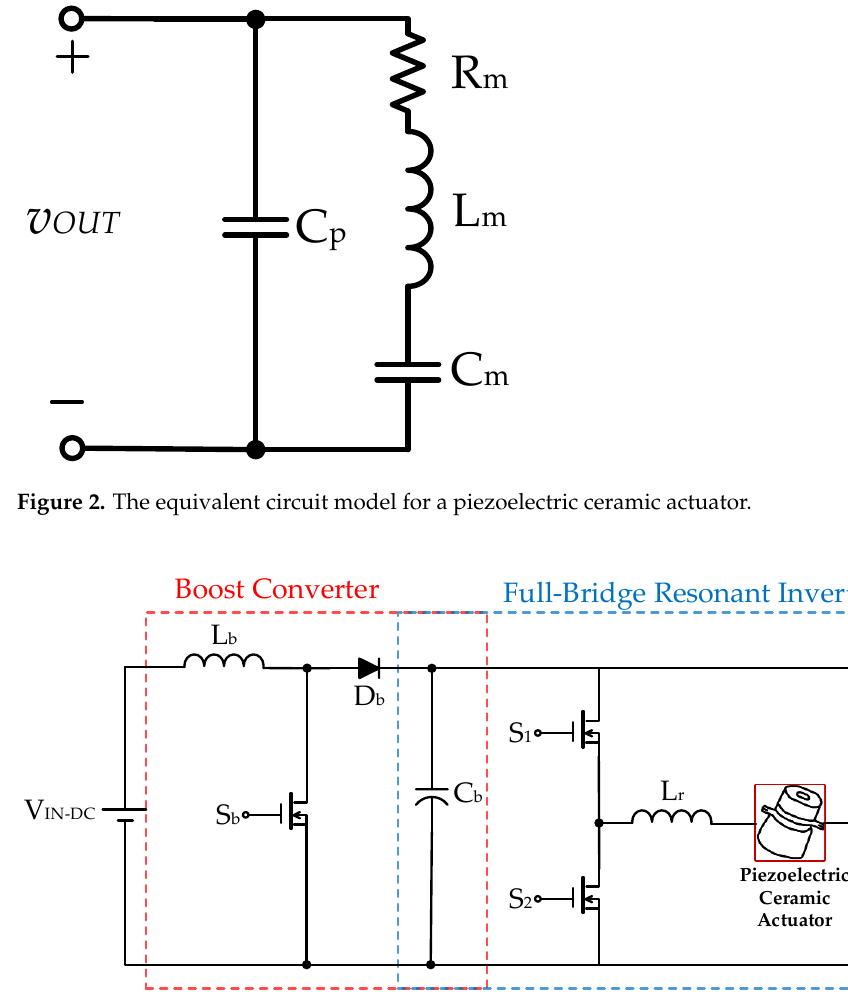
Figure 3. The conventional two-stage drive circuit for supplying a piezoelectric ceramic actuator applied with a DC input voltage source [12].